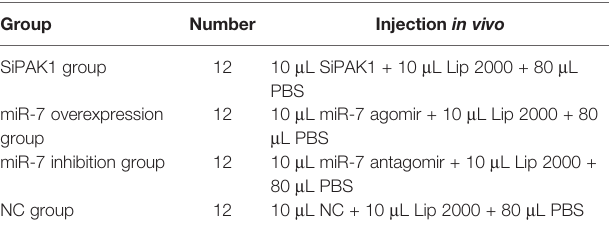
TABLE 3 | Grouping and treatment of sea cucumbers in the phagocytic capacity experiment.